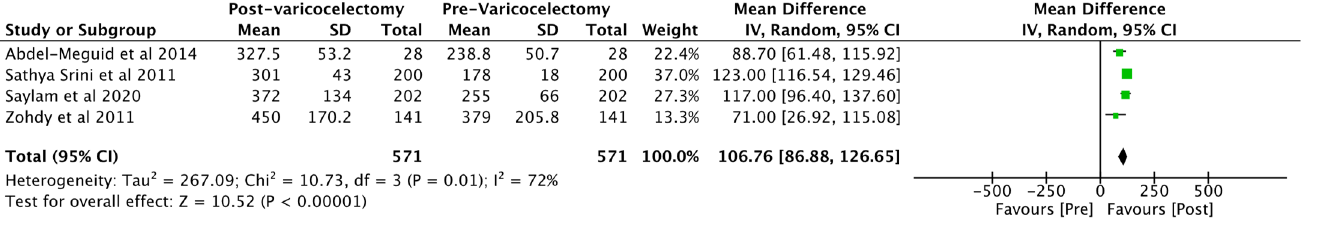
Figure 1. Total testosterone pre- and after-surgery in patients with varicocele. CI = confidence interval; SD = standard deviation.